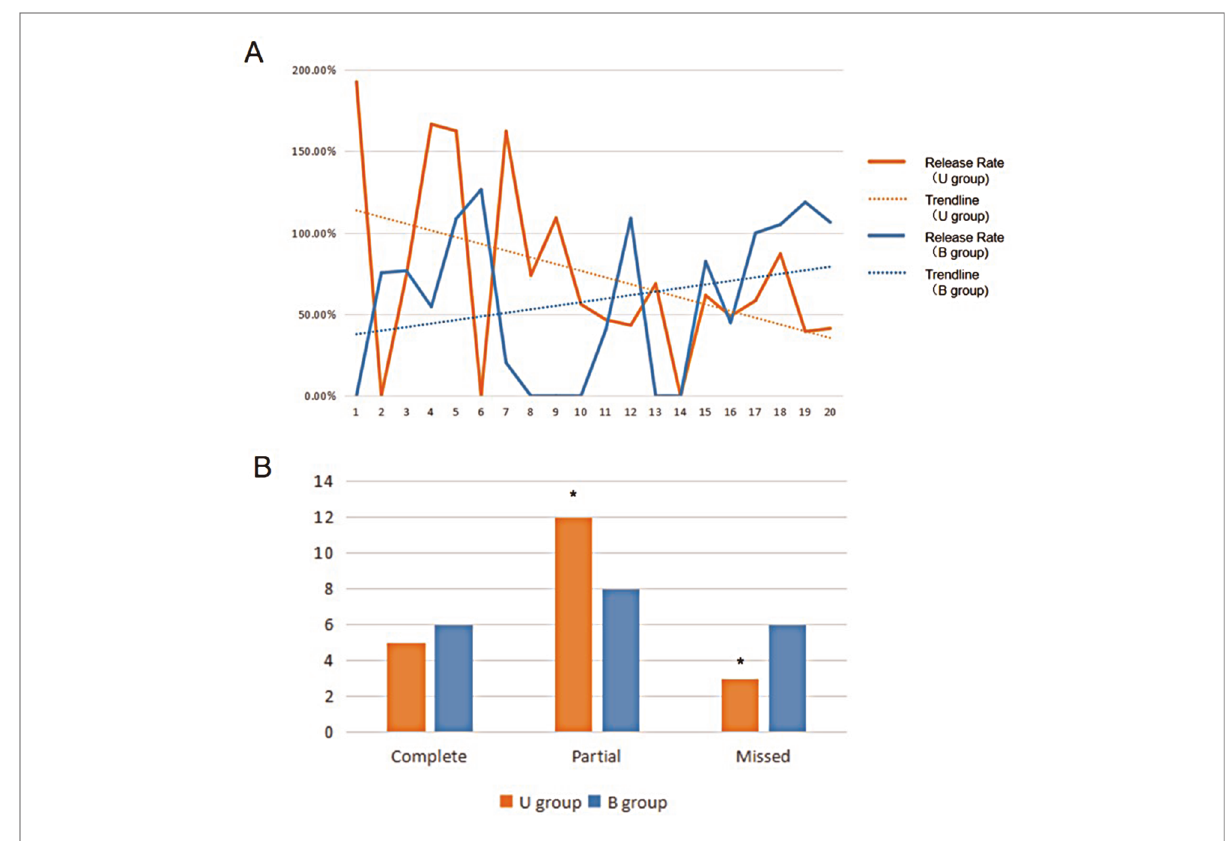
table. Group U-P ( n = 15) received once treatment of ultrasound-guided acupotomy, while Group B-P ( n = 15) received once therapy of blind acupotomy. A blinded research fellow who was not involved in patient care conducted pre- and post-acupotomy therapy clinical outcome assessments. Before, one week after, and one month after receiving acupotomy therapy, symptoms and functional impairment and the Patient-rated Wrist Evaluation